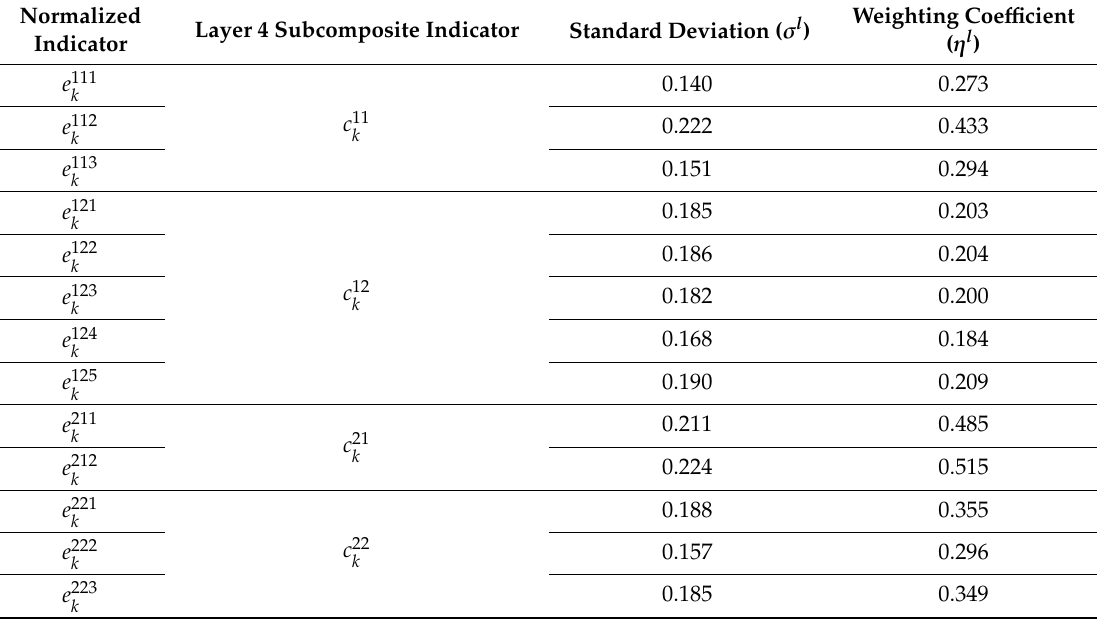
Table 3. Weighting coe ffi cients for calculation of layer 4 composite